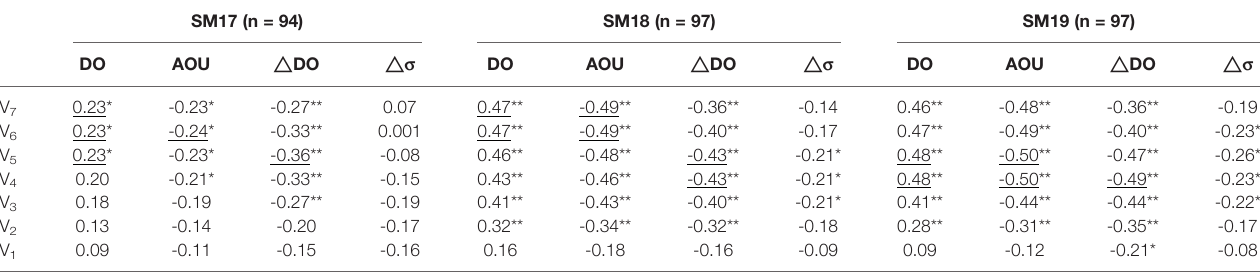
TABLE 2 | The Correlation Coef fi cient r, between bottom DO, AOU, △ DO, △ s and wind speed in summer.